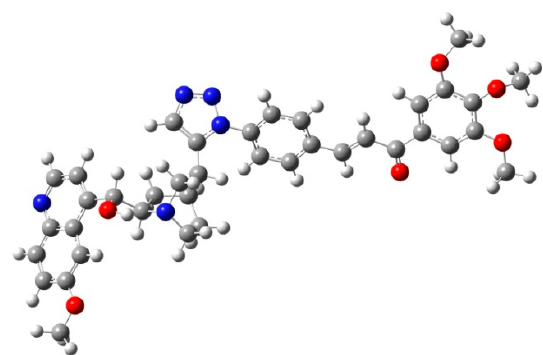
Figure 2. Optimized structure of hybrid 12c generated by B3LYP/6-31+G(d) method in vacuo.